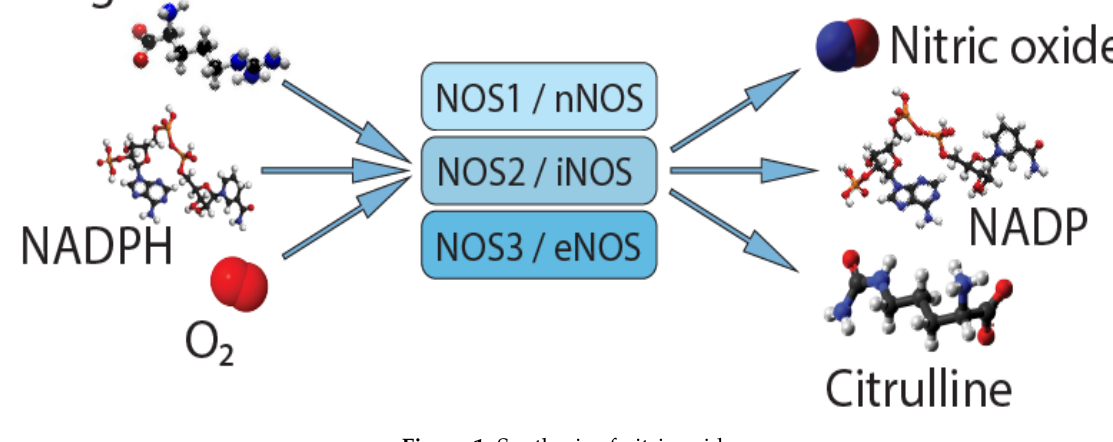
Figure 1. Synthesis of nitric oxide.